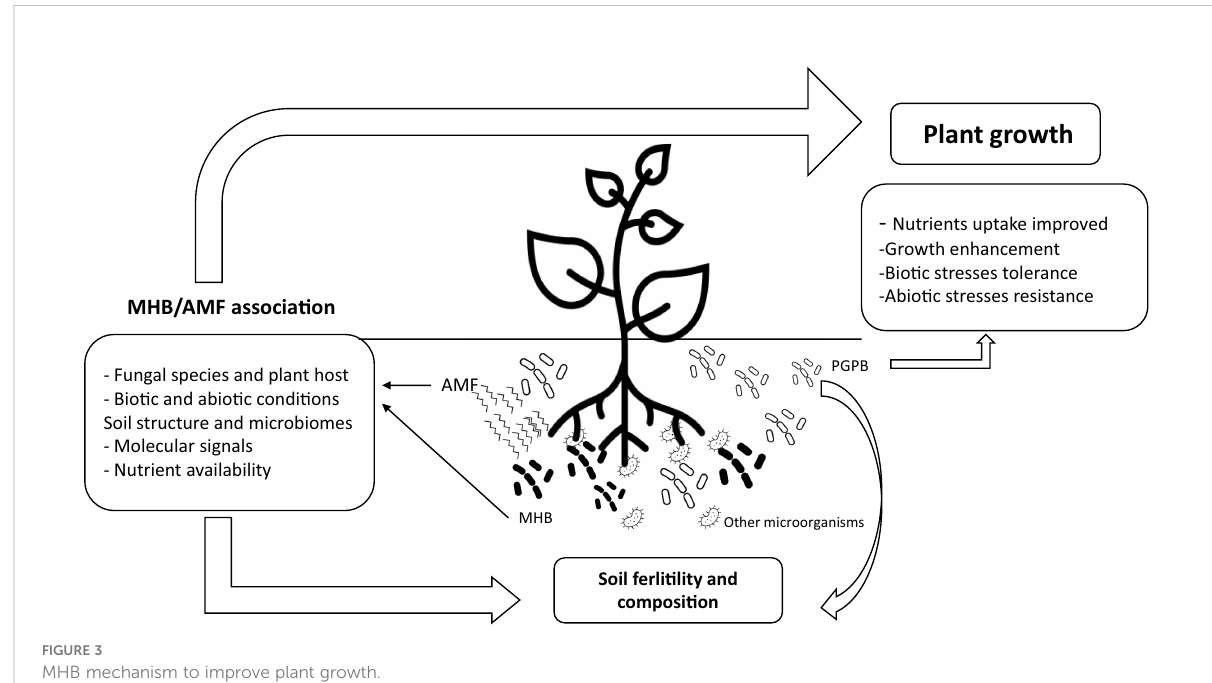
FIGURE 3 MHB mechanism to improve plant